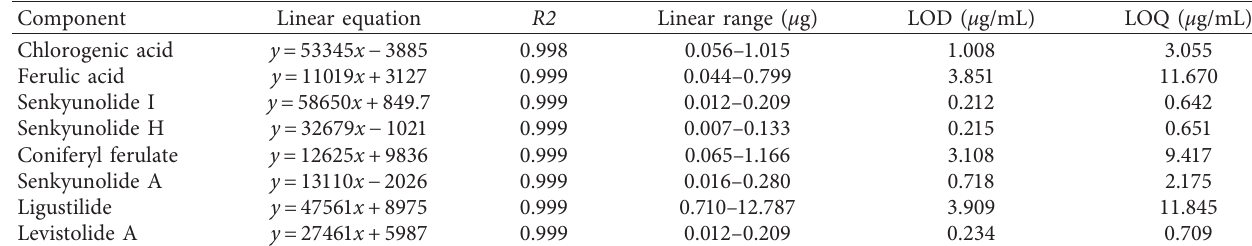
Table 1: Investigation results of linear relationship of 8